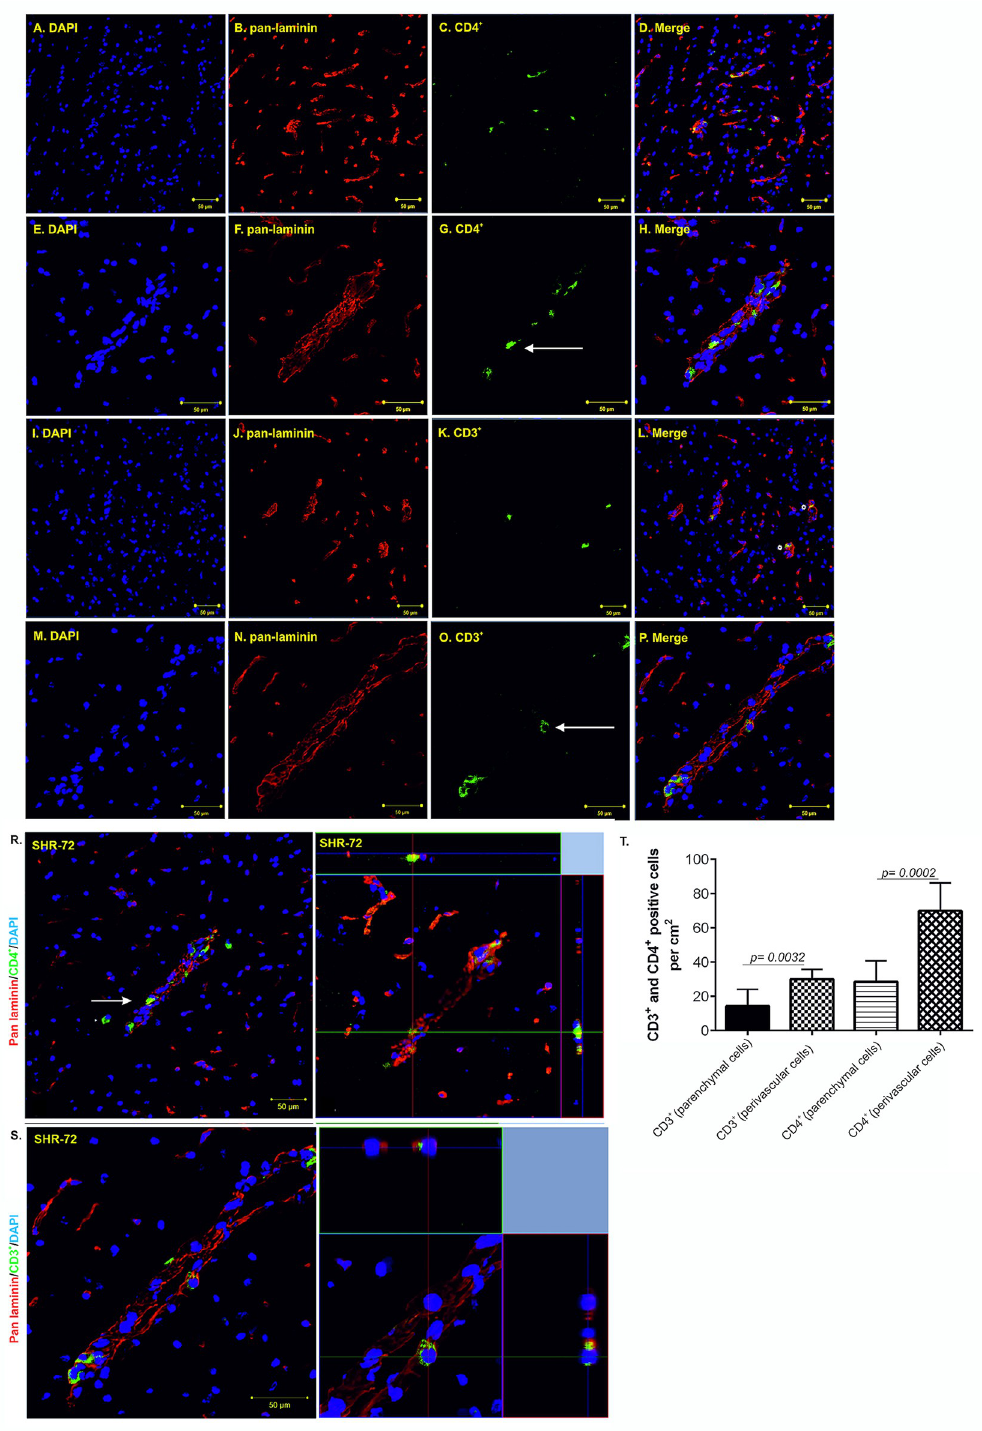
Fig 3. Increased CD3 + and CD4 + T-cell occurrence in the brainstem of SHR-72 transgenic rat model for tauopathies. (A-D) Immunofluorescence staining showed CD4 + T-cells in SHR-72 transgenic animals. (E- H) Immunofluorescence staining showed more perivascular than brain parenchyma infiltrating CD4 + T-cells in SHR-72 transgenic animals. (I-L) Immunofluorescence staining showed CD3 + T-cells in SHR-72 transgenic animals. (M-P; white arrow) Immunofluorescence staining showed mainly intravascular CD3 + T-cells in SHR-72 transgenic animals. (R; white arrow) Presence of CD4